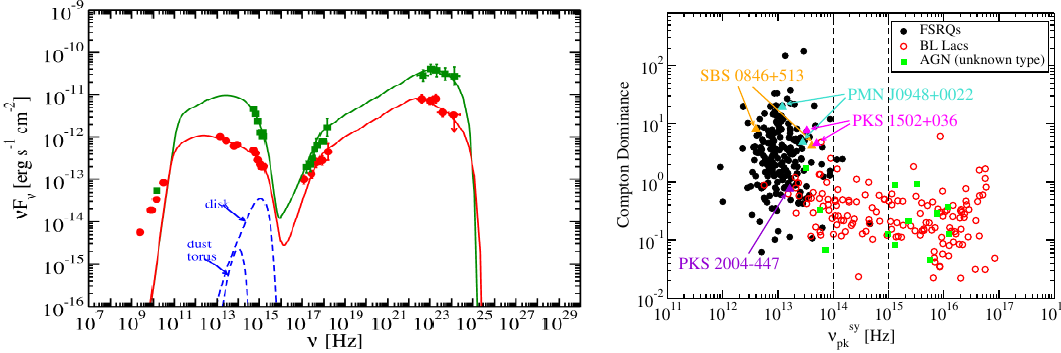
( Left panel ): Spectral energy distribution (SED) and model fit (solid curve) of SBS0846 + 513 in flaring activity (squares) and low activity (circles) with the disk and dust torus emission components shown as dashed curves. Adapted from [21]; ( Right panel ): the Compton dominance versus peak synchrotron frequency for sources from the Second LAT AGN catalog (2LAC) [53], along with two activity states of SBS 0846 + 513 [21], PMN J0948 + 0022 [23], PKS 1502 + 036 [25], and an average state of PKS 2004 − 447 [31]. Dashed lines indicate the boundary between high-synchrotron-peak, intermediate-synchrotron-peaked, and low-synchrotron-peaked blazars. Adapted from [54], reproduced by permission of the